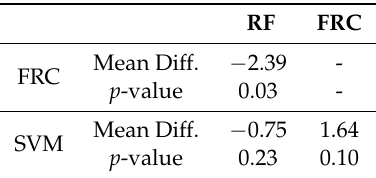
Table 10. Dunn test for coarse-grained classifiers.